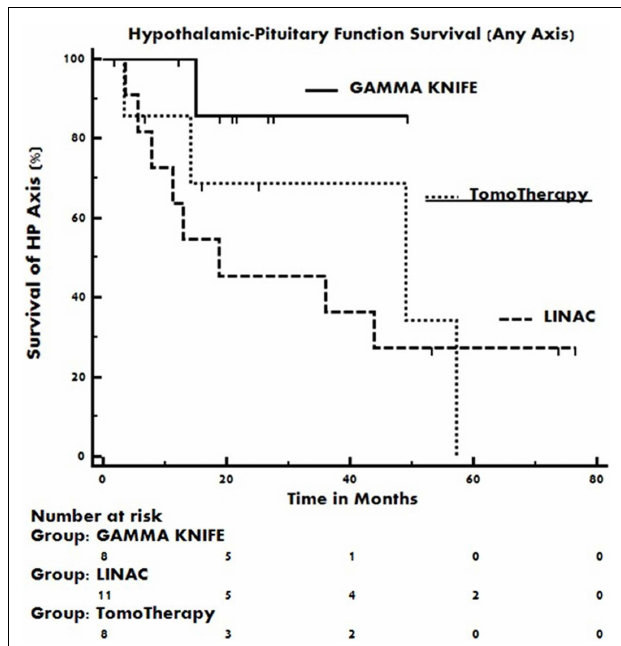
FIGURE 2 | Kaplan–Meier event curves of pre-radiotherapy intact hypothalamic–pituitary axes as a function of time post-radiotherapy . Occurrence of any new endocrinopathy constitutes an event in the plot. Event curve hazard ratios do not differ statistically by the log-rank test.